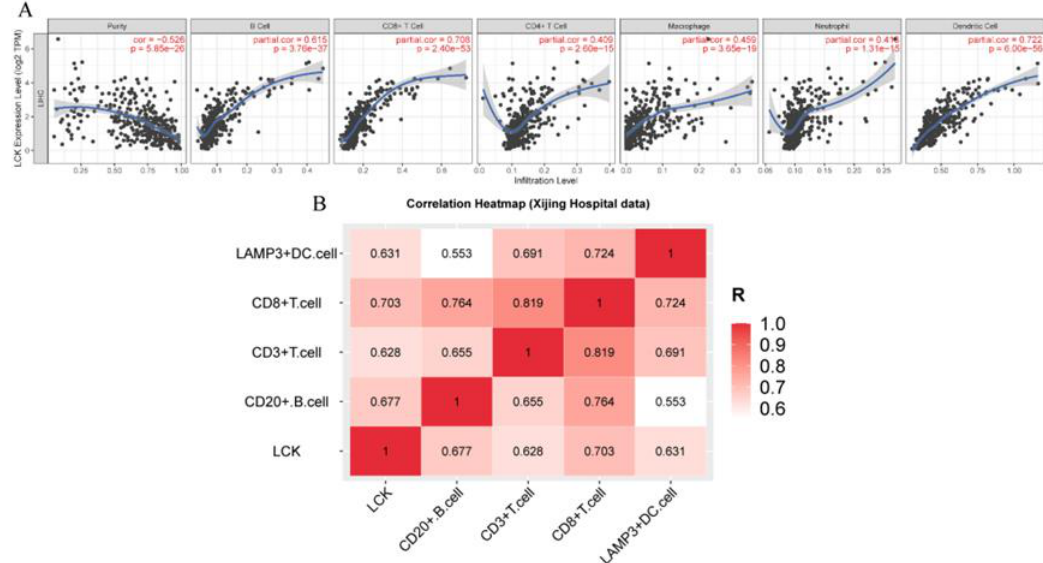
Figure 8. Correlation analysis of LCK expression and levels of tumour-infiltrating lymphocytes: ( A ) TIMER data and ( B ) Xijing Hospital data.